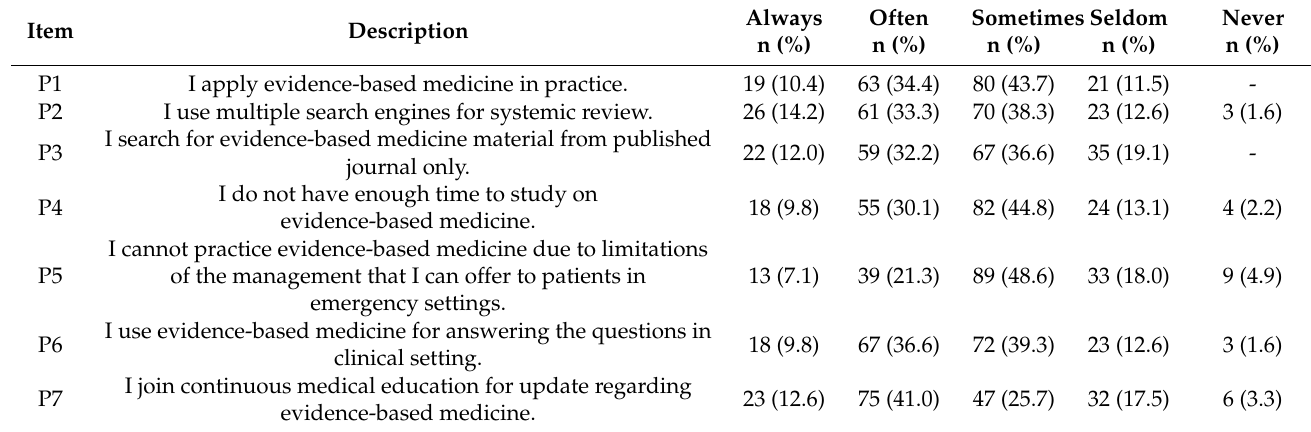
Table A3. Practice related to Evidence-Based